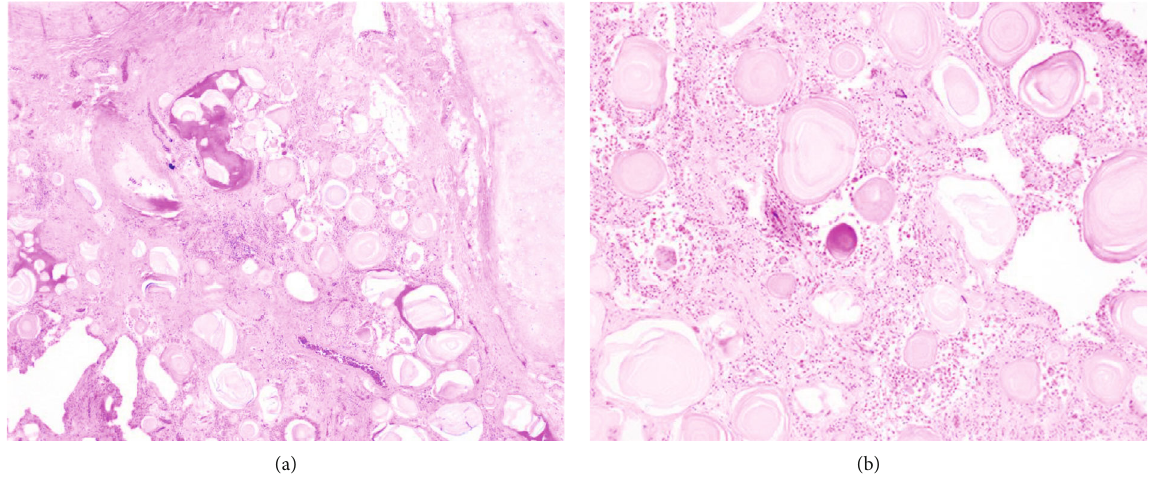
Figure 2: Histologic examination of explanted lung tissue. (a) 4x H&E sections of bilateral lung parenchyma demonstrated similar fi ndings consisting of numerous microliths fi lling alveolar spaces, di ff use interstitial fi brosis, and focal osseous metaplasia. (b) 10x higher magni fi cation showing the characteristic concentric calci fi cation of the microliths and focal osseous